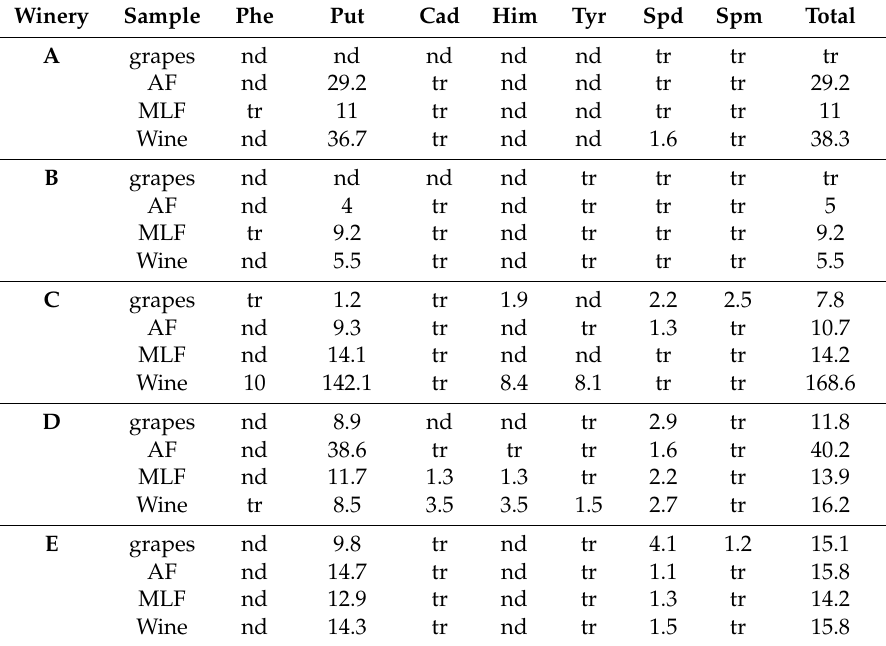
Quantification of biogenic amines (BAs) levels (mg/L) during vinification (from Henriquez-Aedo et al.